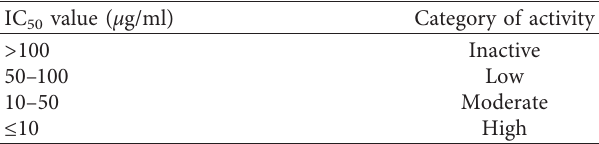
Table 1: Adopted classification of antiplasmodial activity. IC 50 value ( μ